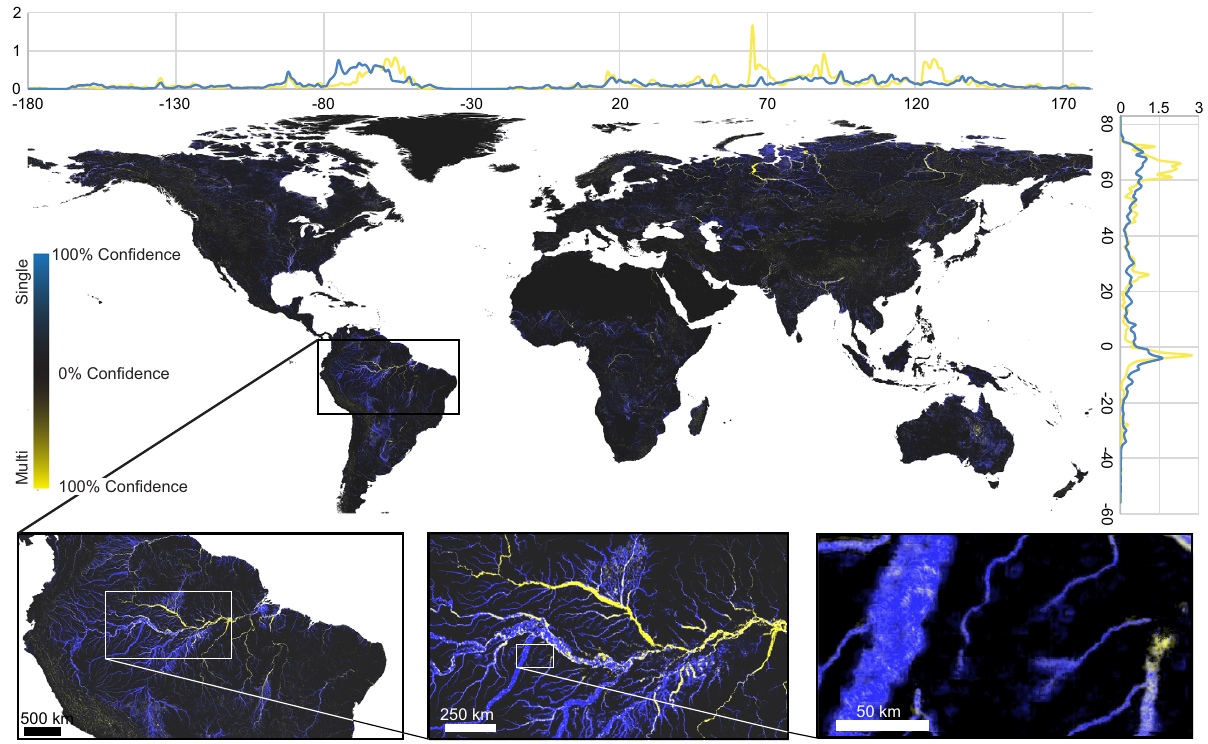
Fig. 3 | Global scale analysis of channel belt extent — map shows the predicted extentofchannelbeltsandthesingle-versusmulti-threadplanformcharacter of its river channel. Latitudinal and longitudinal plots show the proportion of